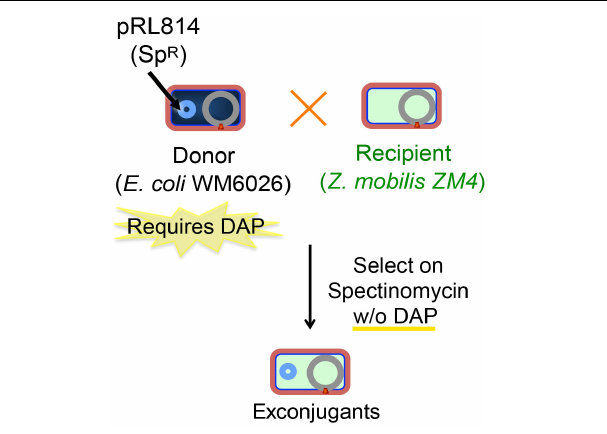
FIGURE 1 | Scheme for conjugation of plasmids from E. coli to Z. mobilis. Z. mobilis (light blue) was conjugated using the DAP auxotrophic E. coli strain WM6026 (dark blue) as described in the section “Materials and Methods.” Briefly, donor and recipient strains were mixed and incubated in ZRMG containing tryptone and DAP overnight at 30 ◦ C. The conjugation mixture was recovered in liquid ZRMG medium at 30 ◦ C for 2 h, and plated in ZRMG with appropriate